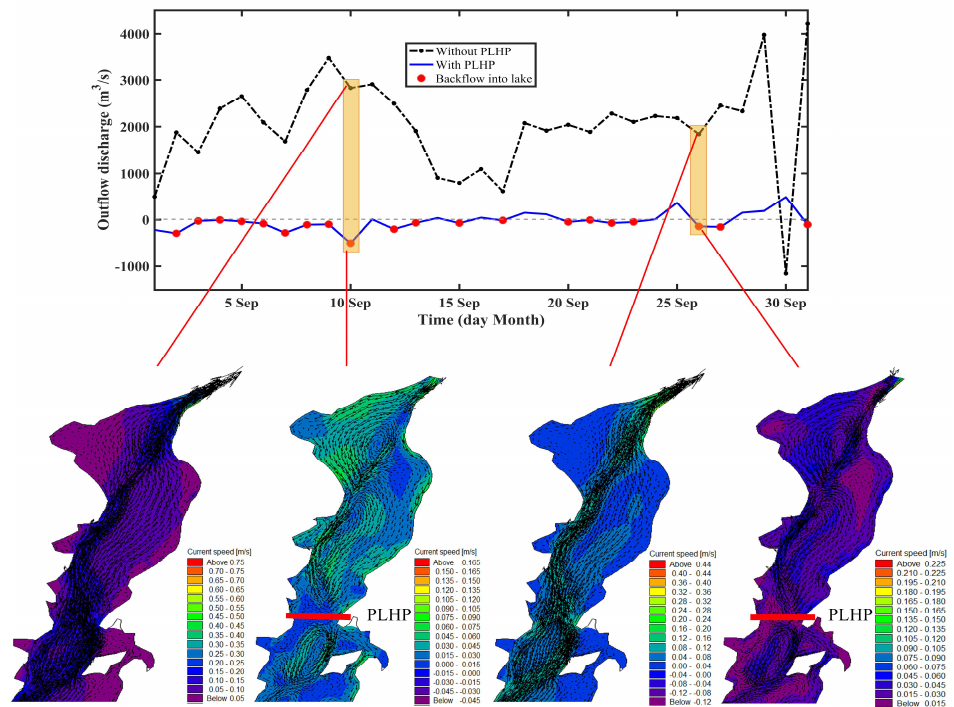
Figure 9. Influence of the PLHP on lake outflow discharges during the study period. The close up for the northern lake outflow channel (zoomed in) indicates the current vectors. Different velocity scales in the sub-panels aimed to distinguish velocity magnitudes for the two time slices.